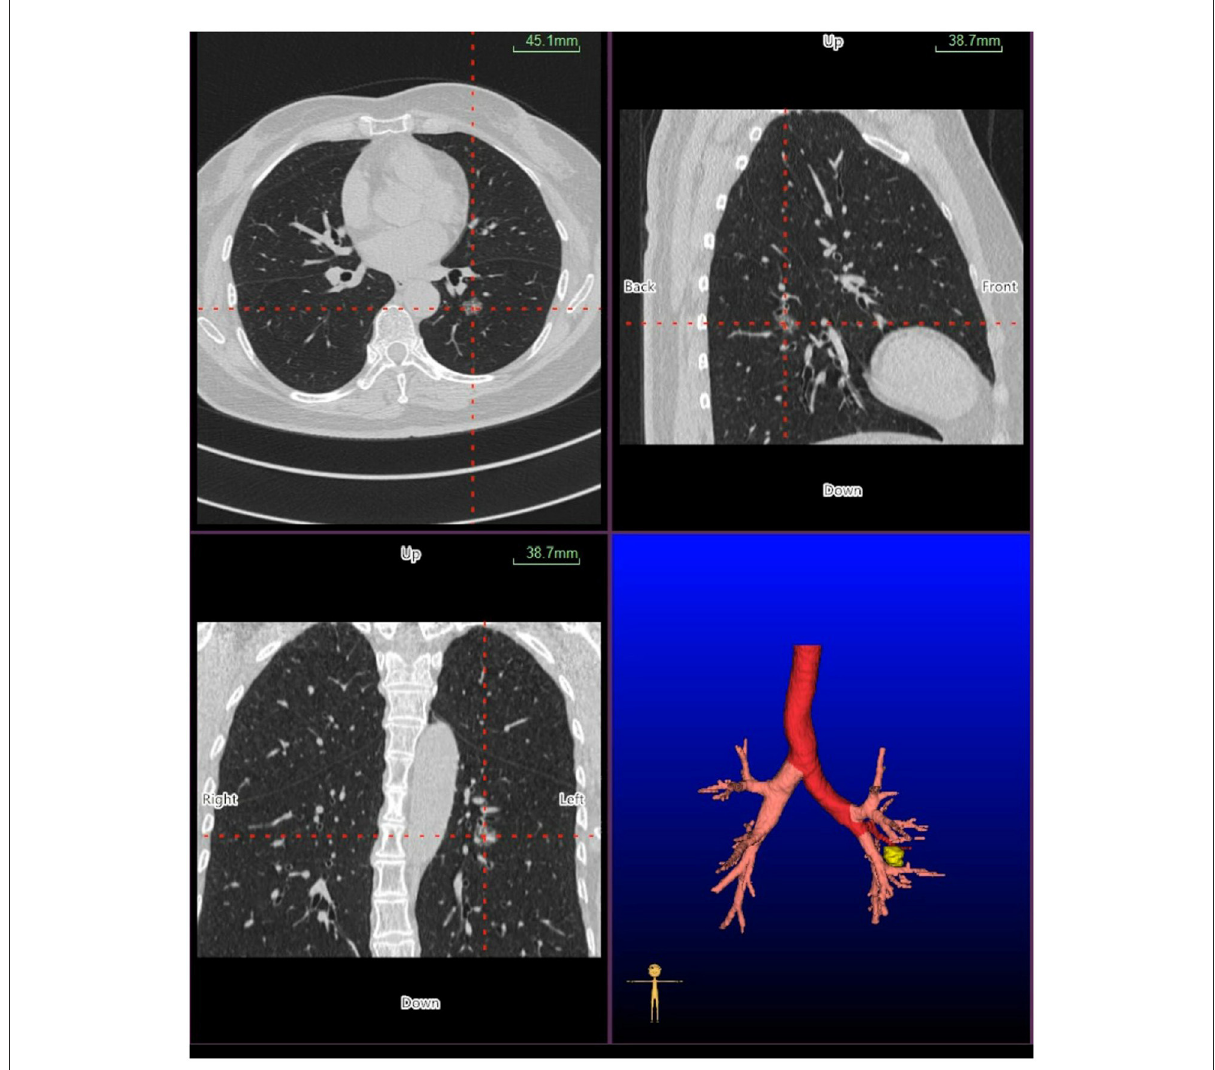
FIGURE2 Planning phase- multi-planar views of the target peripheral pulmonary lesion (axial, sagittal, coronal, and 3D